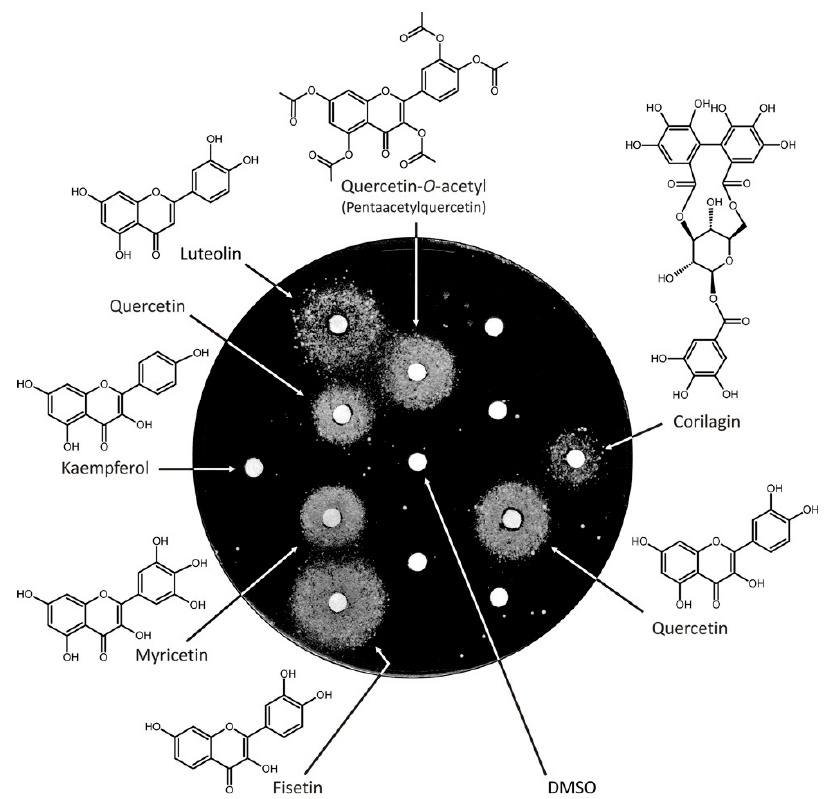
Figure 2. Flavonoids and tannins are chemical suppressors of vps13 ∆ growth defect. The vps13 ∆ strain was plated on YPD + SDS 0.03%. Luteolin was used as a positive control and DMSO as the vehicle control. Kaempferol is indicated as an example of a non-active flavonoid in the conditions used. Compounds were applied at 30 µg per spot. Plates were incubated for 5 days. Two quercetin samples from separate stocks were used.